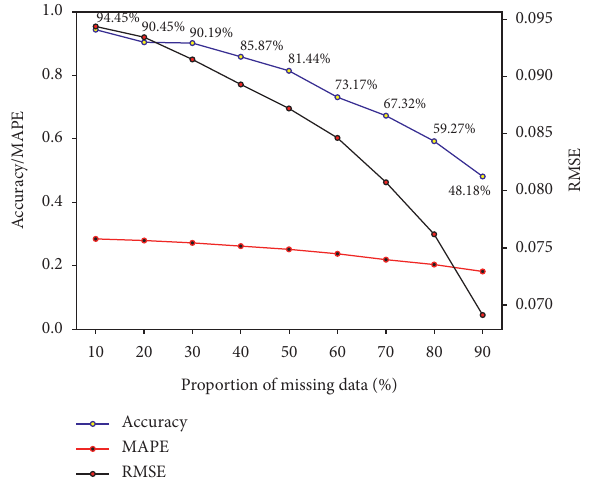
Figure 7: Performance of the model ( P � 24, Q � 10, R �